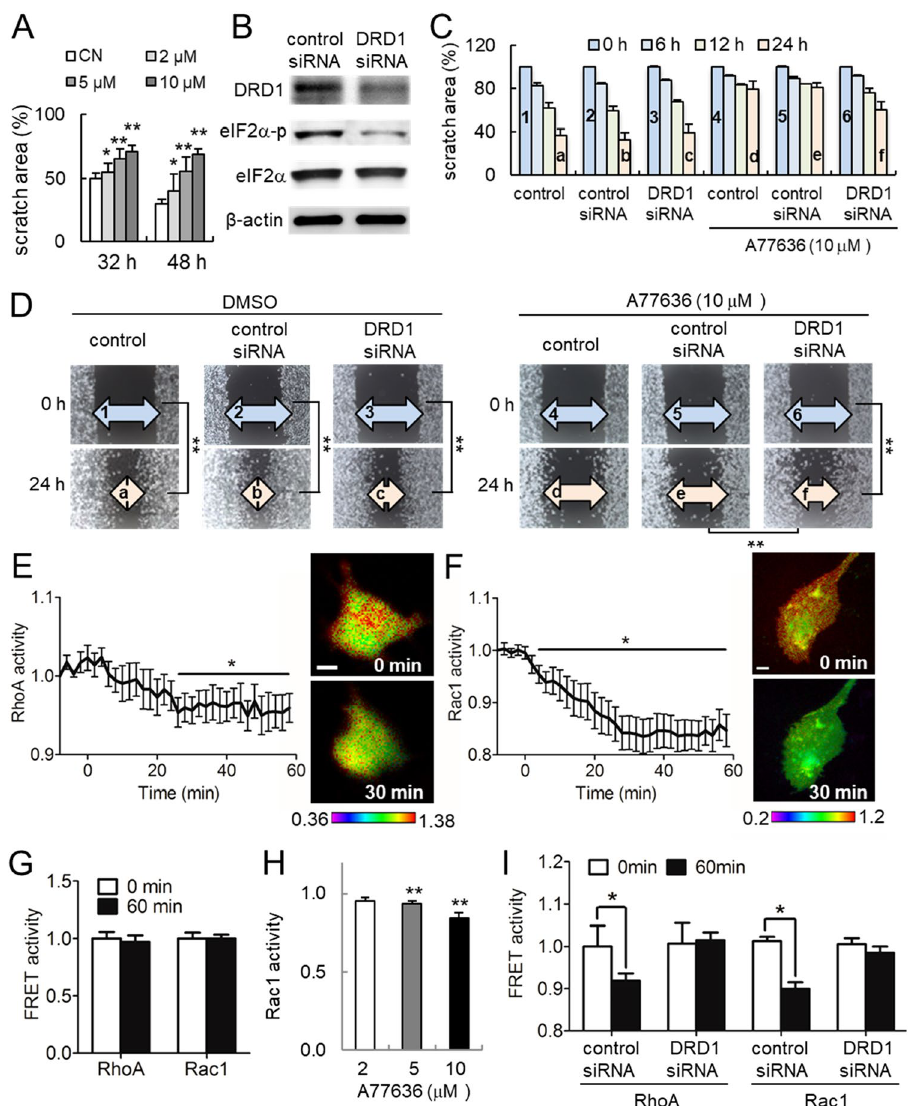
Figure 2. Inhibitory effects of A77636 on the migration of MD231 cells. The single and double asterisks indicate p < 0.05 and p < 0.01, respectively. ( A ) Dose-dependent suppression of cellular migration in response to 2, 5, and 10 μM A77636. Of note, CN = control. ( B ) Partial silencing of dopamine receptor D1 (DRD1) with DRD1 siRNA. ( C , D ) Wounded area with and without DRD1 siRNA in the presence and absence of 10 μM A77636. The double asterisk indicates p < 0.01. ( E , F ) FRET-based activities of RhoA and Rac1 GTPases, respectively, in response to 10 μM A77636. ( G ) Stationary FRET-based baseline activities of RhoA and Rac1 GTPases in the absence of A77636. ( H ) Rac1 activity after 1 h treatment with 1, 5, and 10 μM A77636. ( I ) FRET- based RhoA and Rac1 activities in the presence and absence of DRD1 siRNA in response to 10 μM